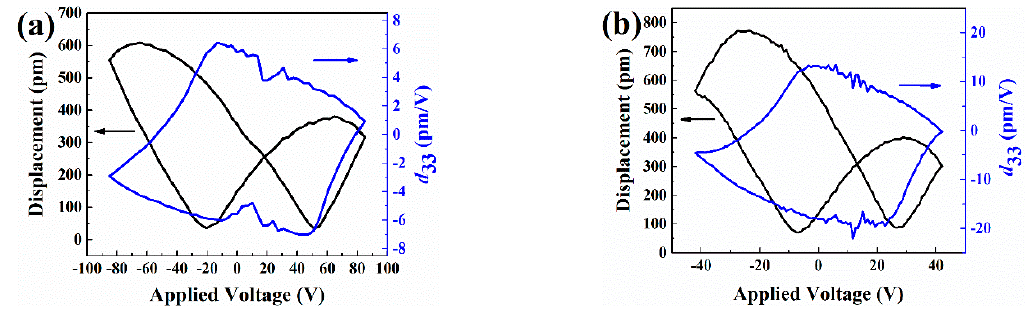
Figure 5. The butterfly and piezoelectric coefficients curves of BFO NWs (( a ) and ( b ) are the results corresponding to NWs in Figure 2a and 2b, respectively). corresponding to NWs in Figure 2a,b,